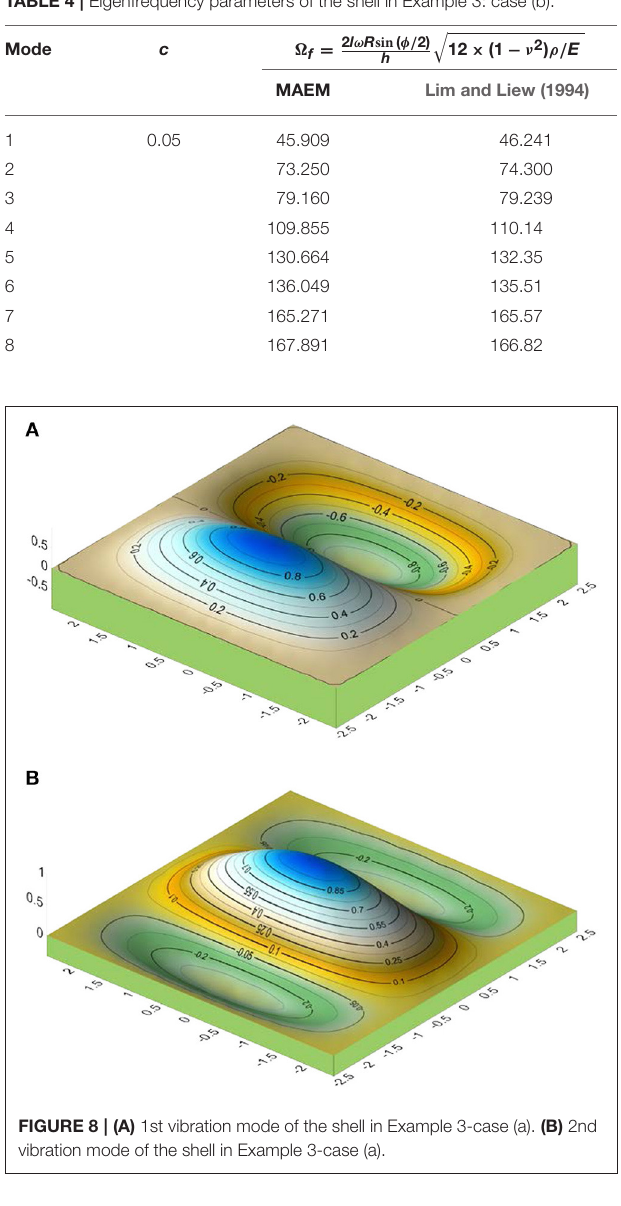
TABLE 4 | Eigenfrequency parameters of the shell in Example 3: case (b).